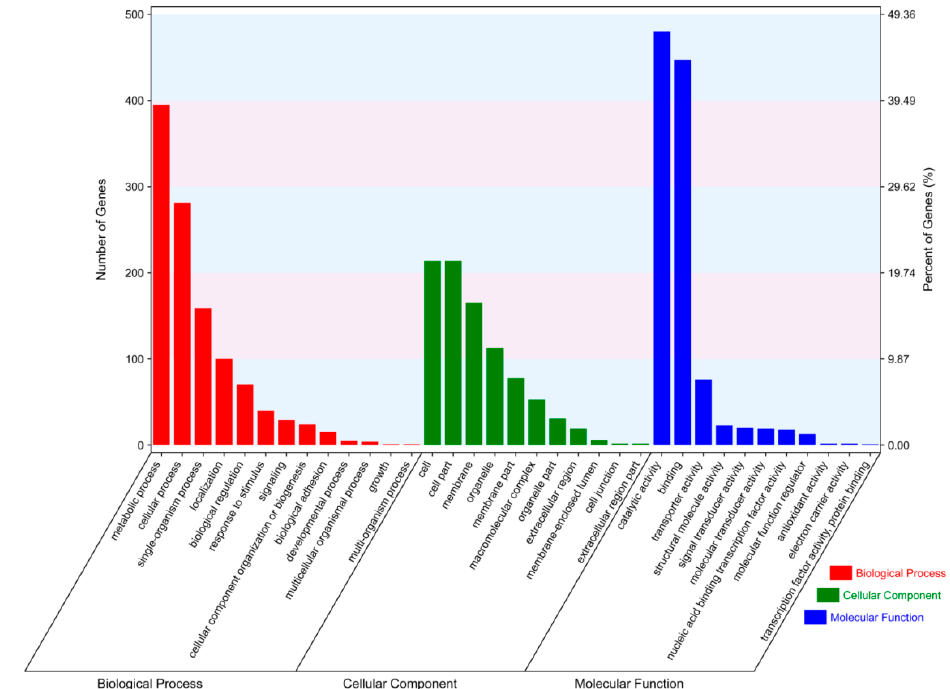
Figure 2. GO term enrichment analysis of the DEGs, classified based on BP, CC, and MF.